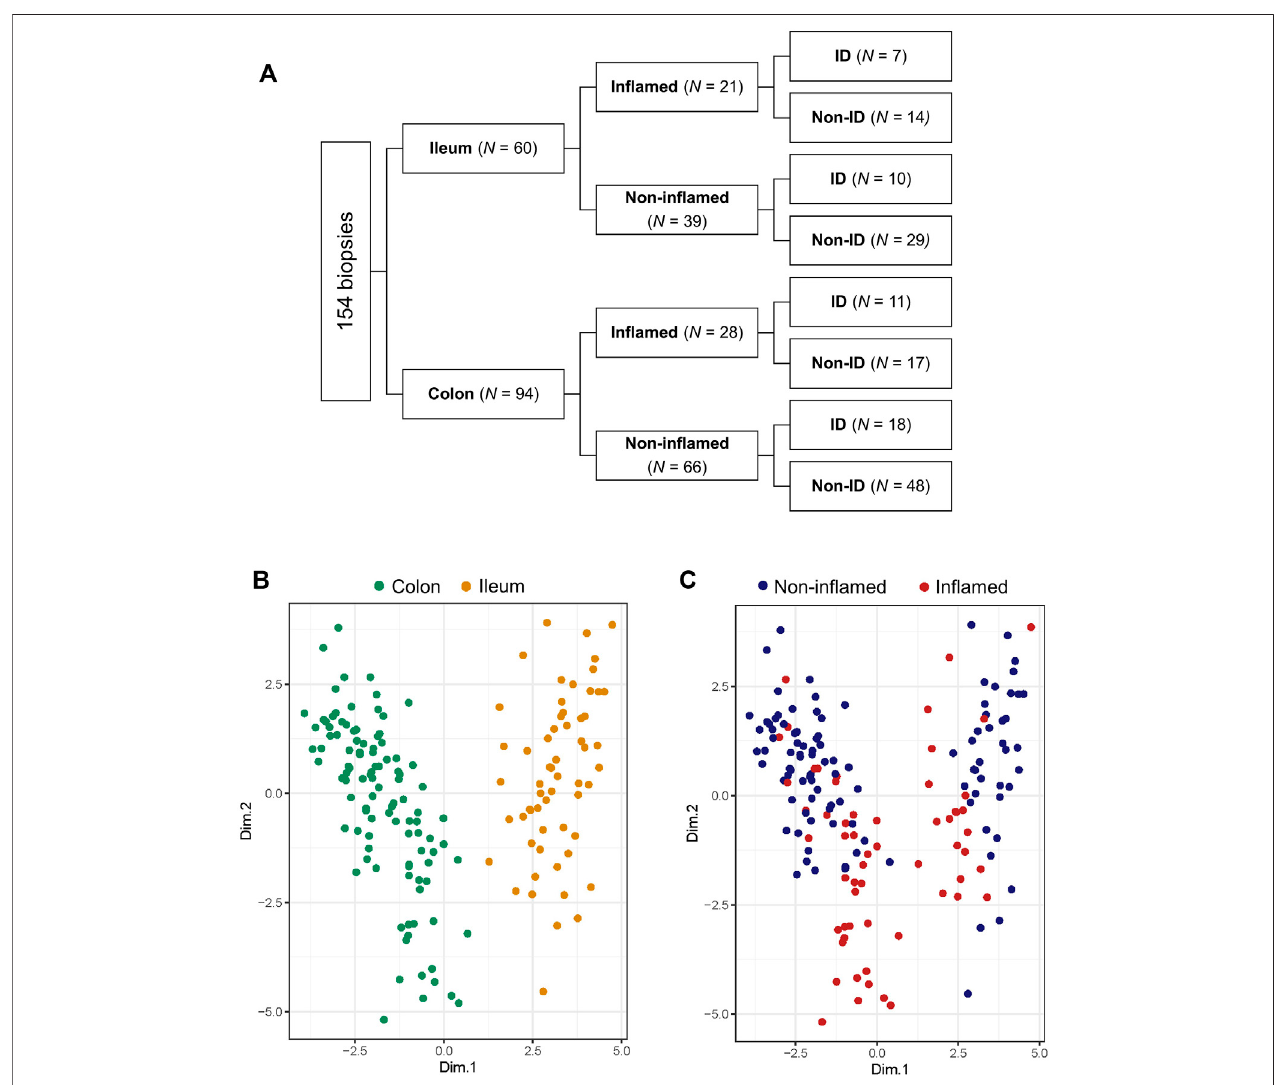
FIGURE 2 | (A – C) Biopsy location and in fl ammatory status contribute the most to variation in gene expression. (A) Diagram showing subdivision of biopsies dependingonlocation,in fl ammatorystatusandironde fi ciency(ID)statusandbiopsycountpergroupanalyzedbyRNAsequencing.Principalcomponentanalysis(PCA) targeted for (B) biopsy location and (C) in fl ammatory